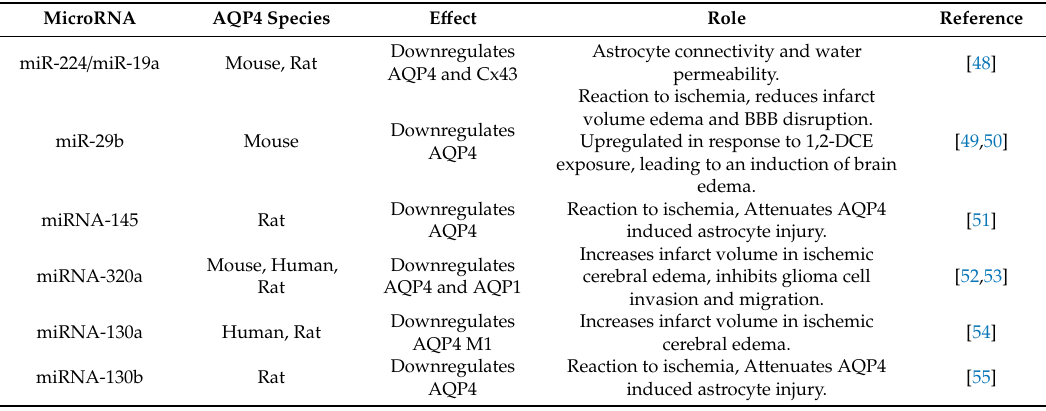
Table 1. A summary of known MicroRNAs which have an e ff ect on Aquaporin-4 (AQP4) gene expression, including which species of AQP4 the microRNAs (miRNAs) is known to be a ffi liated with, the proteins targeted by the miRNA, and the role each miRNA has in endogenous conditions. MicroRNA AQP4 Species E ff ect Role Reference Downregulates Astrocyte connectivity and water Mouse, Rat AQP4 and Cx43 permeability.